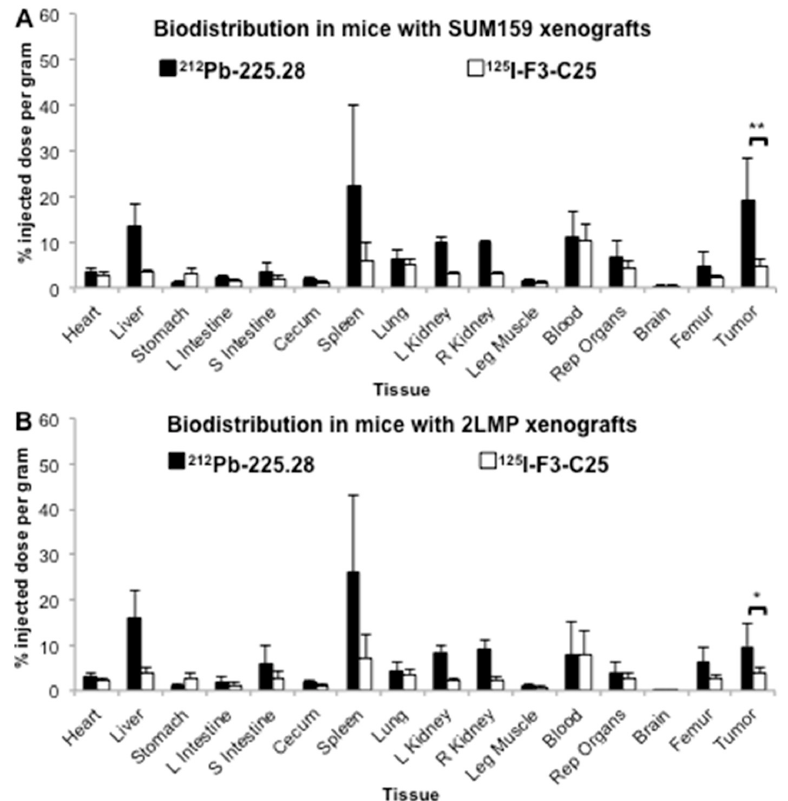
Figure 2. Biodistribution results in athymic nude mice bearing human TNBC xenograft tumors. Groups of mice ( n = 5/group) bearing large SUM159 xenografts ( A ) or 2LMP xenografts ( B ) were injected